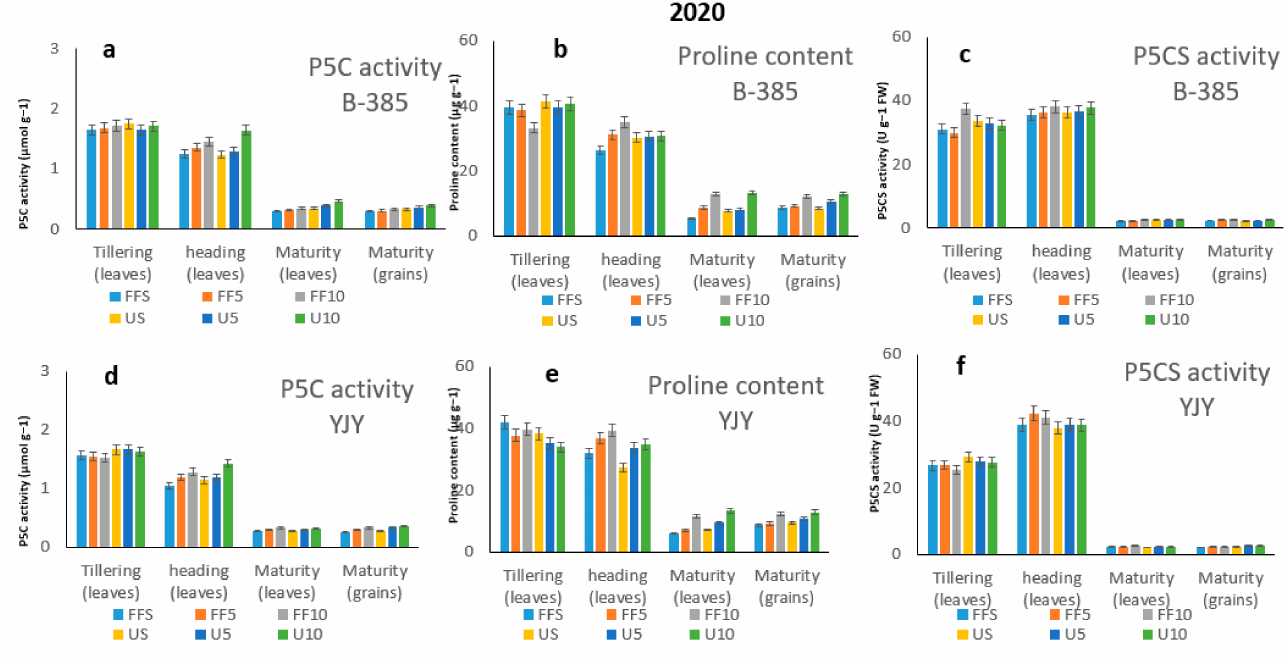
Figure 6. Aroma-related substances’ activities in the leaves and grains at different growing stages under fertilizer application in 2020. ( a ) P5C activity ( µ mol g − 1 ) in B-385 rice cultivar under